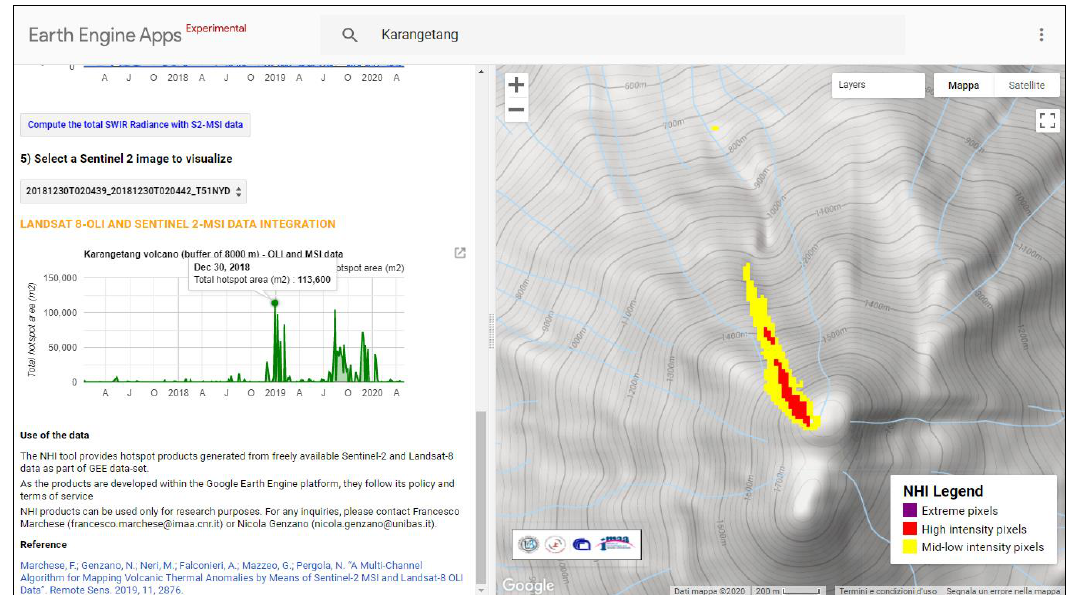
Figure 5. Karangetang ( 2°46′40″N 125°24′27″E ) thermal activity of 1 January 2017 − 30 April 2020; in green, chart of total hot spot pixel area. On the right, thermal anomaly map from Sentinel-2 MSI data of 30 December 2018.